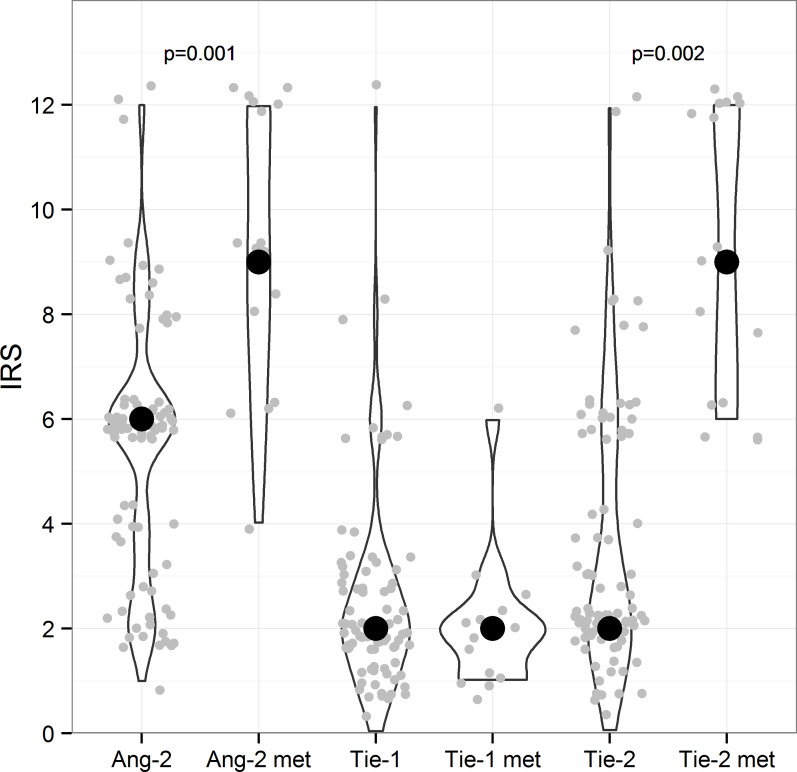
Immunohistochemical staining scores of primary tumors and metastases.IRS was calculated from the tumor epithelium of 86 primary ovarian tumors and 16 metastatic lesions (grey dots). Ang-2, Tie-1 and Tie-2 groups include 86 ovarian cancer patients each and Ang-2met, Tie-1met and Tie-2met groups have 16 patients each. Wilcoxon signed-rank test was used to compare the IRS values for primary tumors and related metastases. Significant p-values are marked in the Figure. The median IRS of the group is signed with a black dot. Ang-2 met Angiopoietin-2 metastasis, IRS immunoreactive score.